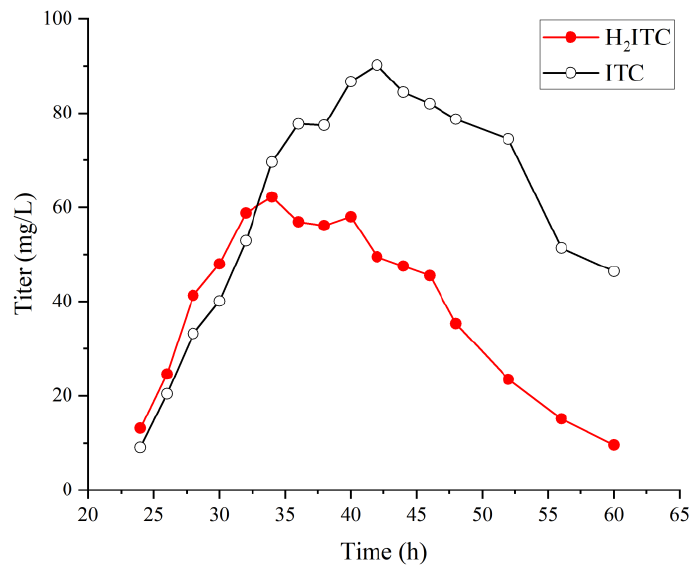
Figure 3. H 2 ITC and ITC titers of Streptomyces sp. CPCC 204095.